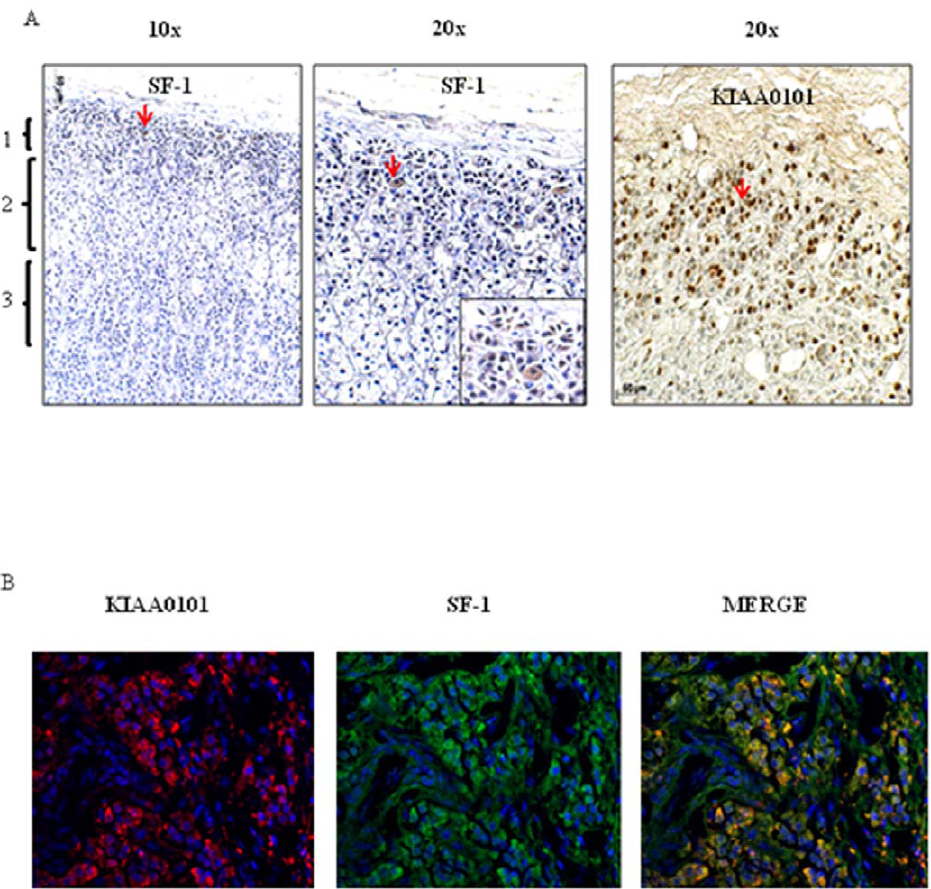
Figure 2. KIAA0101 and Steroidogenic factor 1(SF-1) protein expression in progenitor cells of normal adrenal cortex tissue by immunohistochemistry and immunofluoroscence. A ) Immunohistochemistry staining of normal adrenal cortex for SF-1 and KIAA0101. In the first panel, the zones of the adrenal cortex are indicated at 10X, 1: Zona glomerulosa containing progenitor cells, 2: Zona fasciculata, 3: Zona Reticularis. Second and third panel indicate the SF-1 (20X with 40X inset) and KIAA0101 positive immunostaining in the Zona Glomerulosa at 20X magnification. Red arrows indicate the positive areas for SF-1 and KIAA0101 staining. B ) Immunofluoroscence for SF-1 and KIAA0101 in the normal adrenal cortex. Nuclei were stained by DAPI (blue), red color indicates KIAA0101 expression and green color indicates SF-1 expression. Merged Images (yellow color) at 40X show colocalization of the two proteins, SF-1 and KIAA0101 in progenitor cells of normal adrenal cortex.